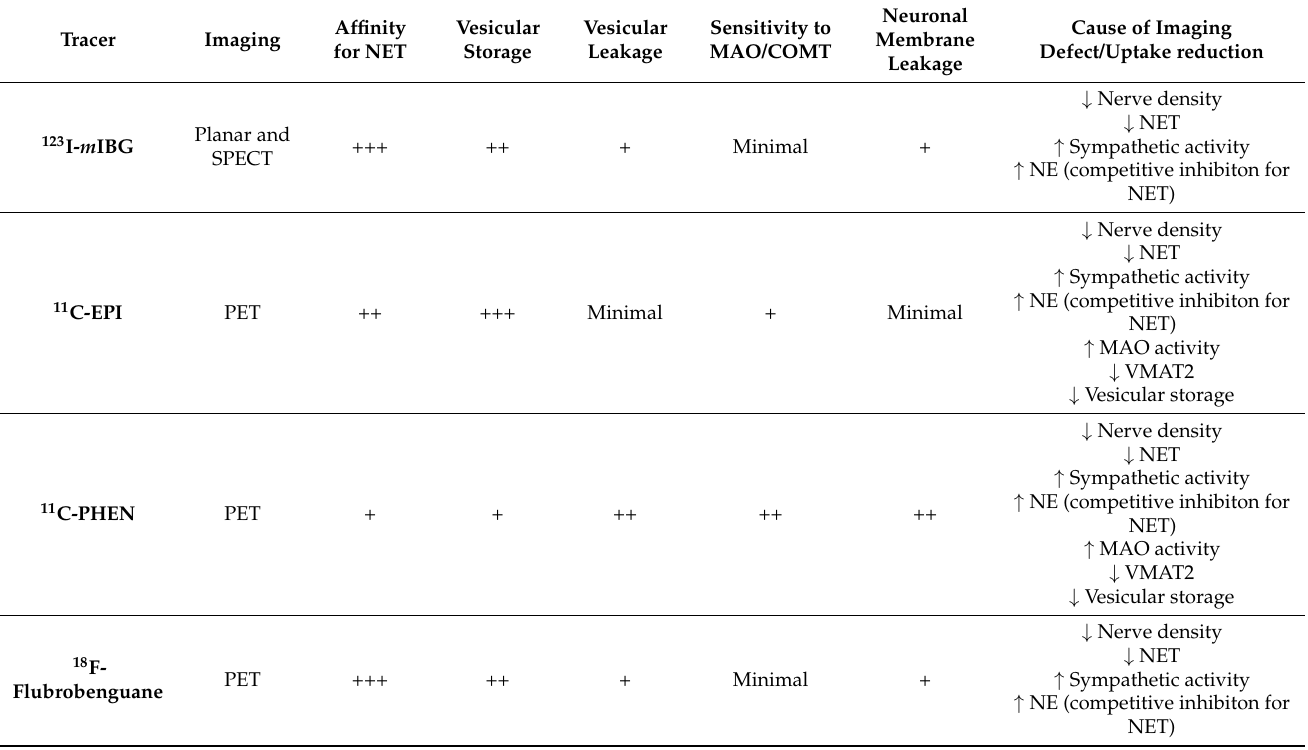
Table 1. Comparison of the neuronal handling of radiotracers for imaging cardiac sympathetic